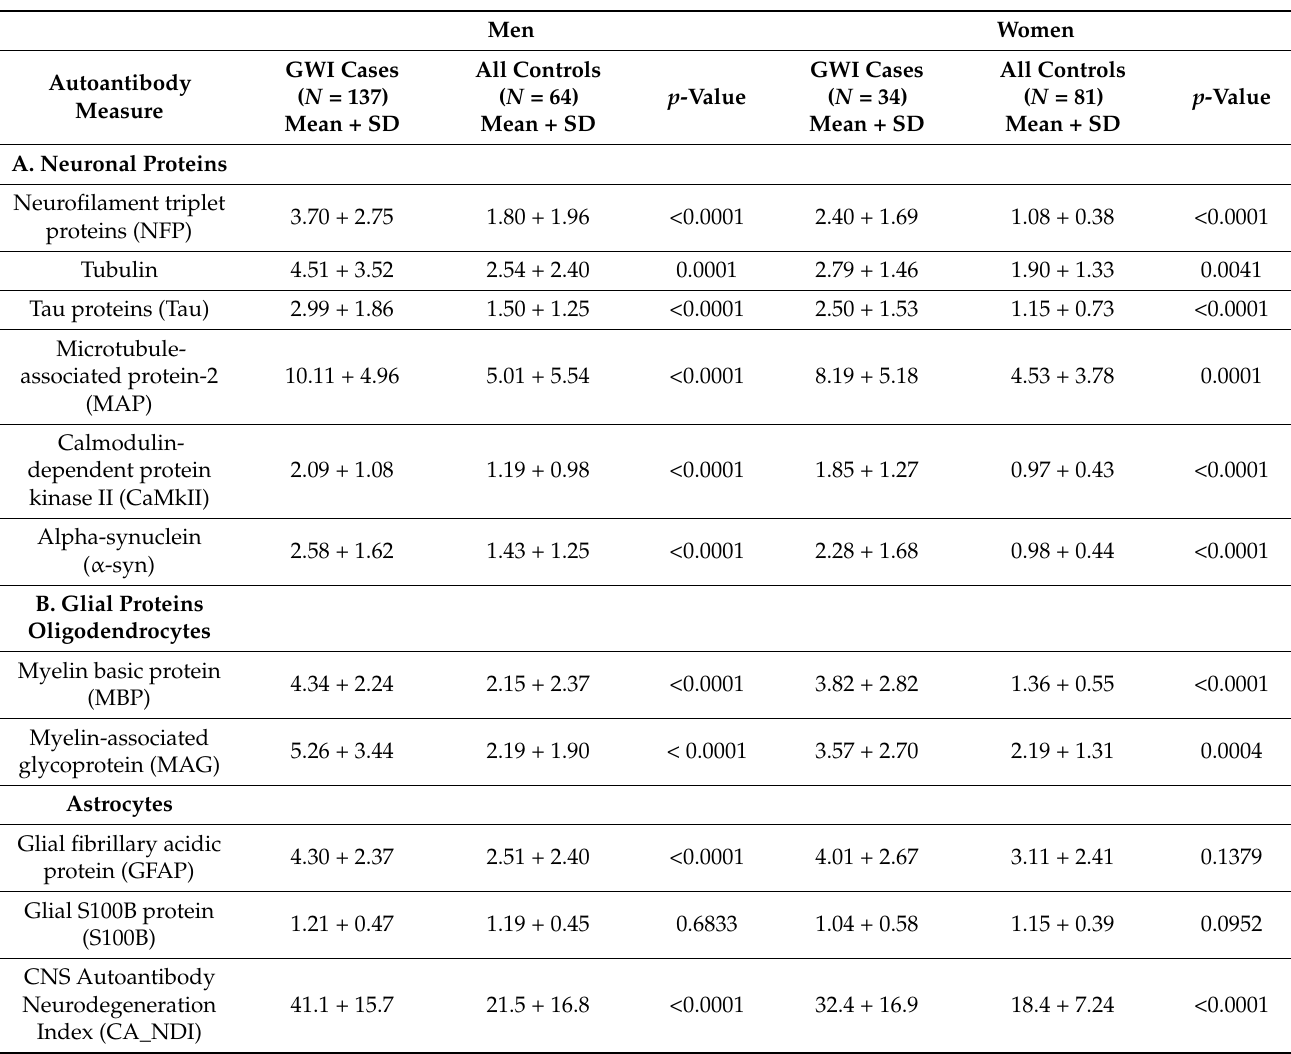
Table 4. ANCOVA analysis of autoantibody differences between men with GWI and all controls and women with GWI and all controls. Men